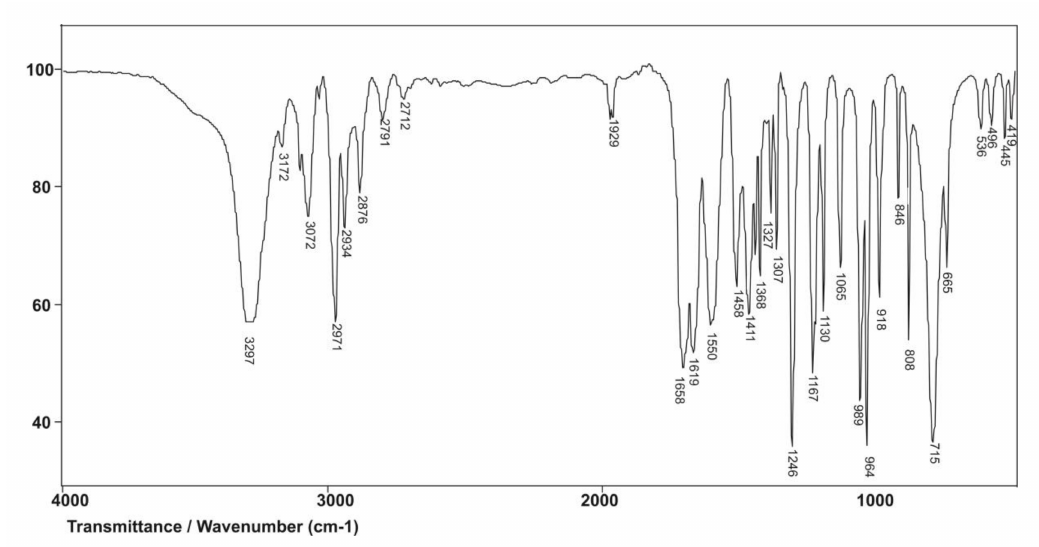
Figure 5. Fourier transform infrared spectroscopy (FTIR) spectrum of the monomer N -isopropylacrylamide,